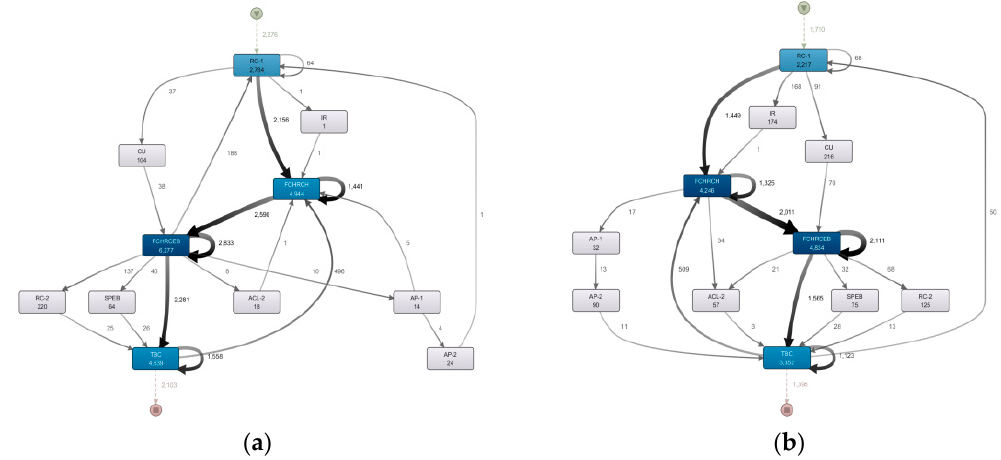
Figure 11. Process models of not in time ( a ) and other cause ( b ) CHS cases.